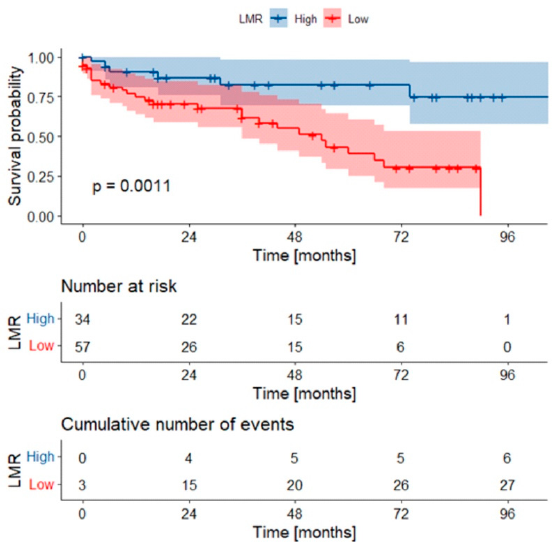
Figure 3. Kaplan-Meier curves with confidence intervals for overall survival stratified by LMR values. p -value was calculated with log-rank test. Abbreviations: LMR: lymphocyte-to-monocyte ratio. Low LMR: below cut-off.